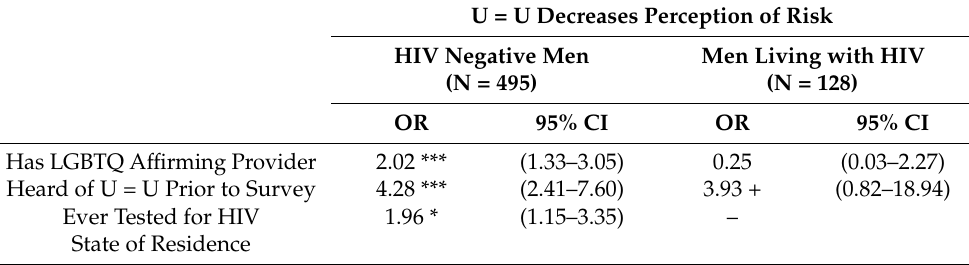
Table 8. Estimates of impact of U = U on risk perception among a sample of midlife and older gay and bisexual men in the US south by HIV status,